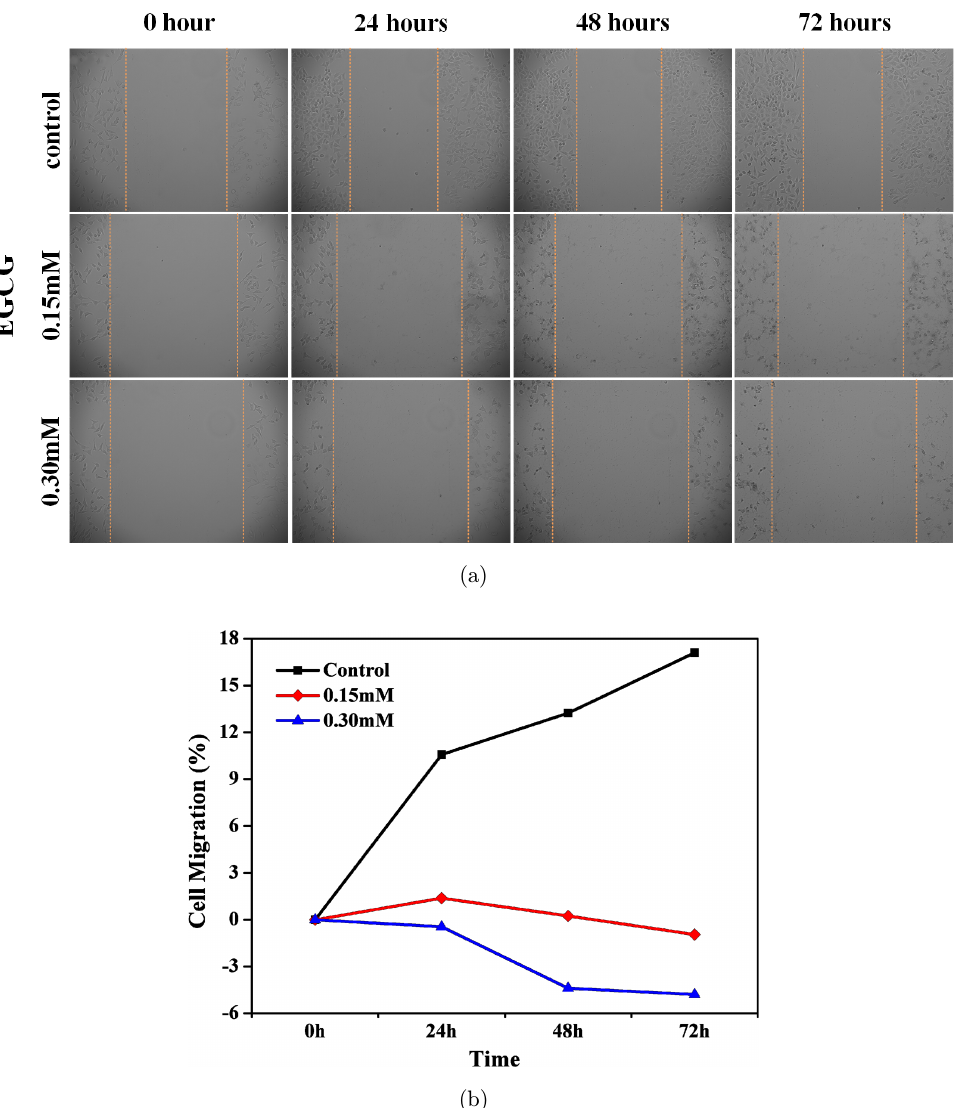
Fig. 7. Wound healing assay in MCF-7 cell culture treated with di®erent concentration. (a) Inversed °uorescent microscope images of the wound healing process monitored for 72 h post-treatment. (b) Quantitative evaluation on the percentage of the wound window closed after